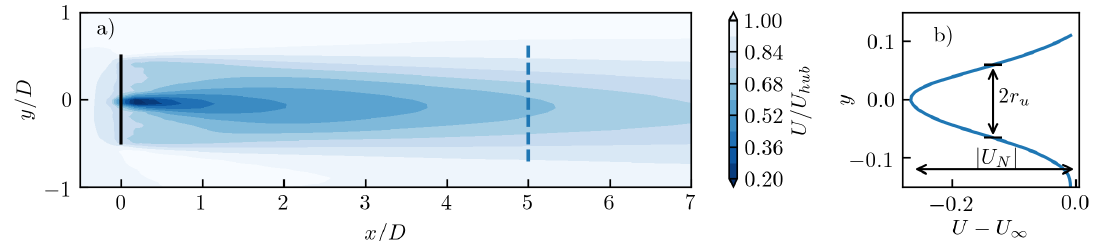
Figure 8. The mean velocity of the turbine wake flow. The bold line in ( a ) represents the rotation region of turbine blades. The velocity along the dashed line in ( a ) is plotted in ( b